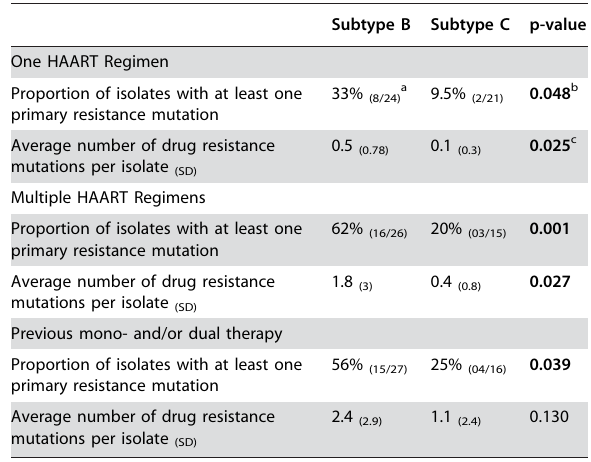
Table 2. Comparison of drug resistance mutation acquisition between subtype B- and C-infected patients under different